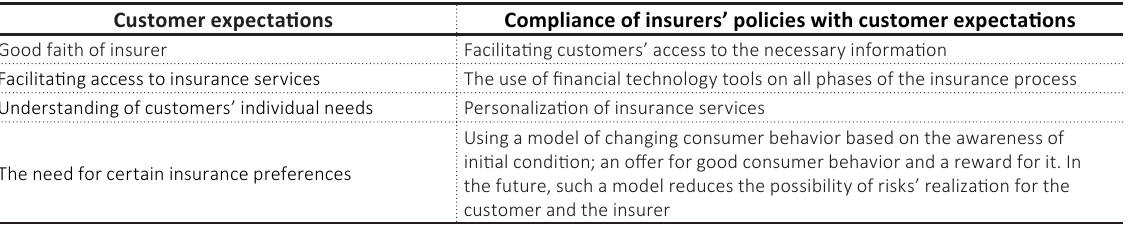
Table 1. Сompliance of insurers’ policies with customer